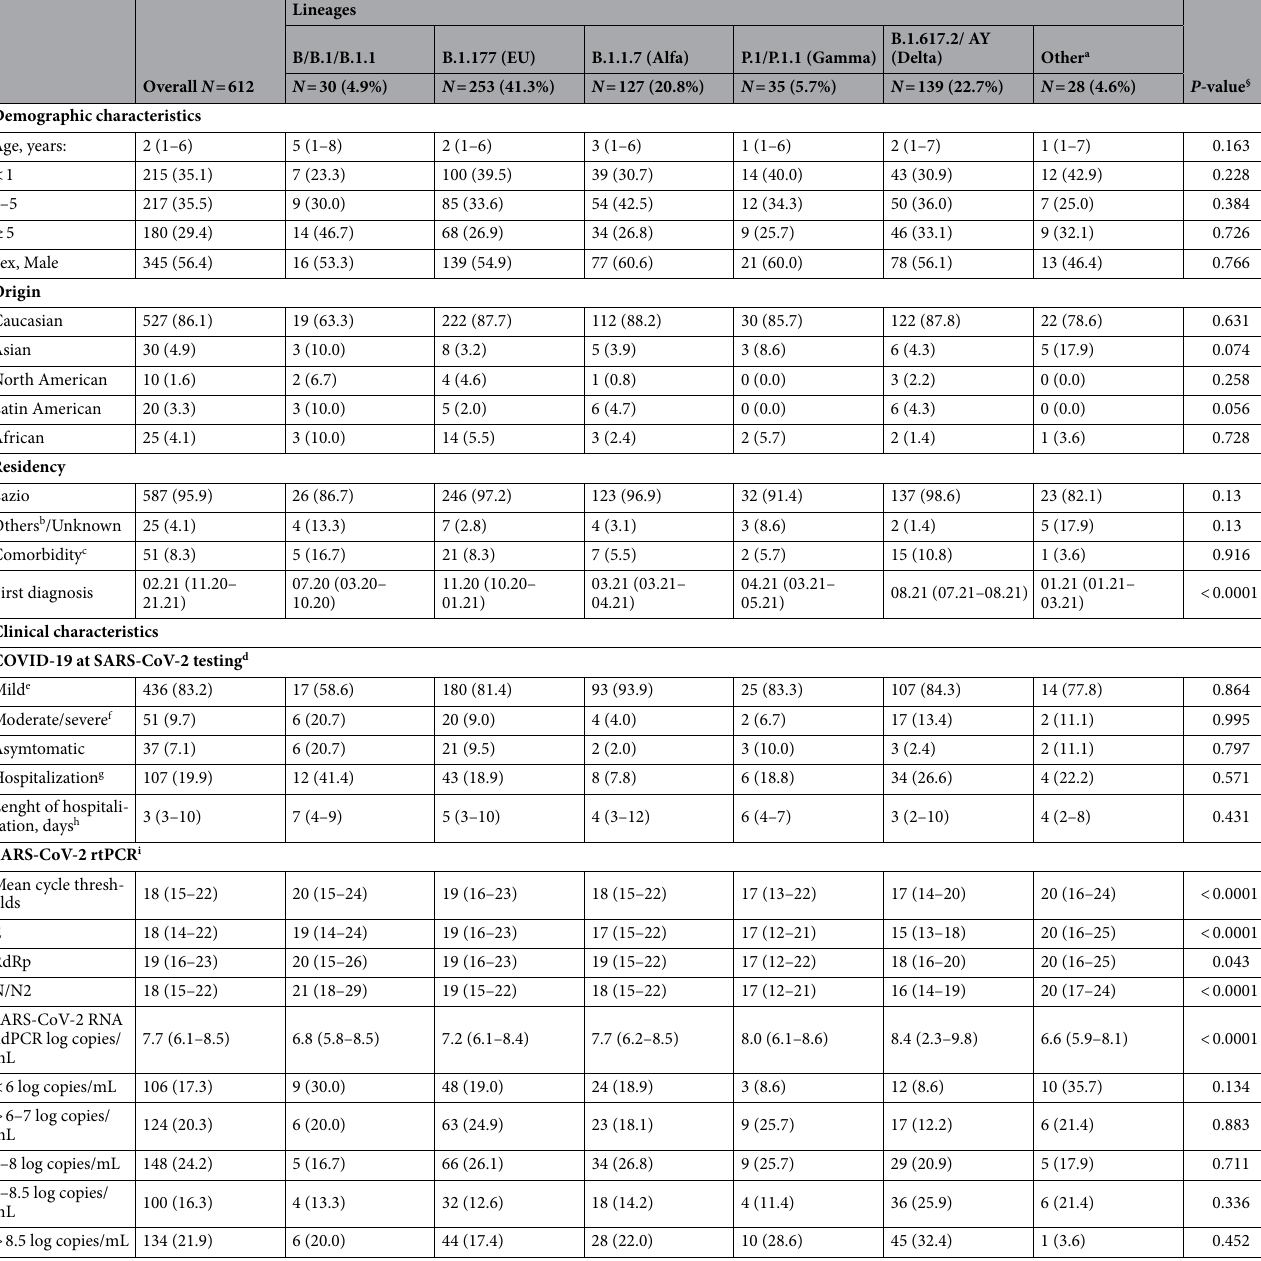
Table 1. Demographic and clinical characteristics of the 612 SARS-CoV-2-infected patients against lineages. Data are expressed as median (IQR), or N (%). § Two-sided P-values were calculated by Kruskal–Wallis test, or Chi-square test for trend, as appropriate. a Includes: B.1.160 ( n = 14), B.1.221 ( n = 2); B.1.258 ( n = 4),